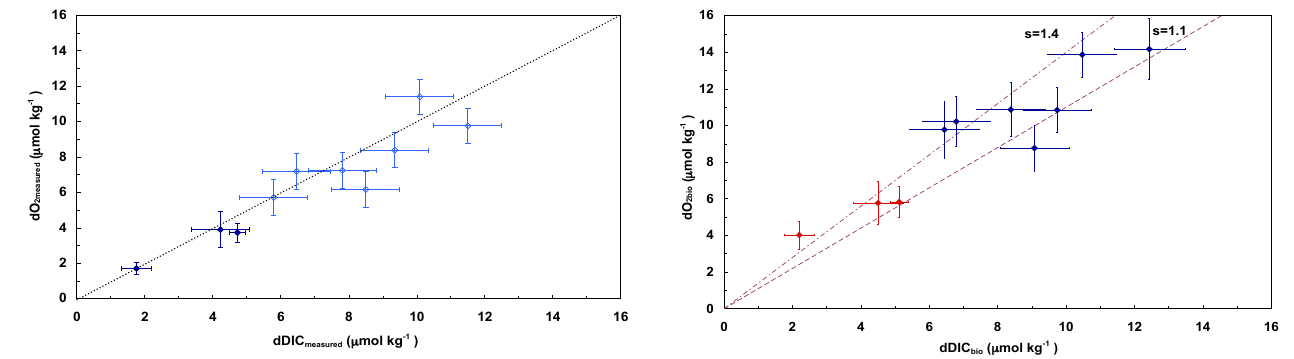
Figure 9. Changes (absolute values) of O 2 (µmolkg − 1 ) attributed to biological activity as a function of changes (absolute values) of DIC (µmolkg − 1 ) attributed to biological activity between consec- utive mornings (red dots) or during the daylight period (blue dots). The two dotted lines with a slope of 1.4 and 1.1, respectively, char- acterize the new and regenerated production